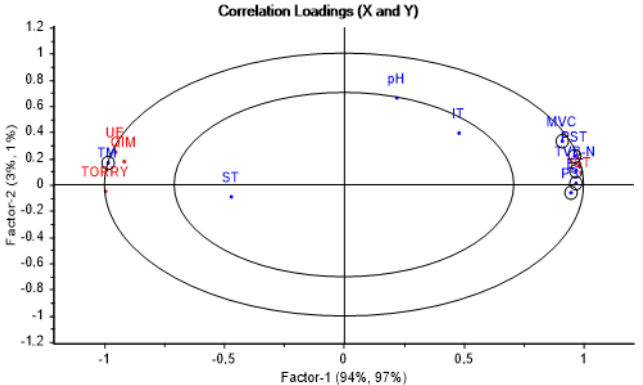
Figure 2. Relation of sensory freshness index (y) and physico–chemical and microbiological parameters (x) by partial least squares (PLS) regression for sea bream during storage in ice. IST: Ice storage time elapsed (h), SFI: Sensory freshness index, TORRY: SFI by Torry scale, QIM: SFI by Quality Index Method, EU: SFI by EU Official method, TM: Torrymeter (STD scale), TVB-N: Total volatile basic nitrogen (mg* 100g−1 of fresh fish), pH: pH, ST: temperature on surface (°C), IT: internal temperature (°C), MVC: mesophilic viable count (log CFU/g), ET: Enterobacteriaceae (log CFU/g), PST: